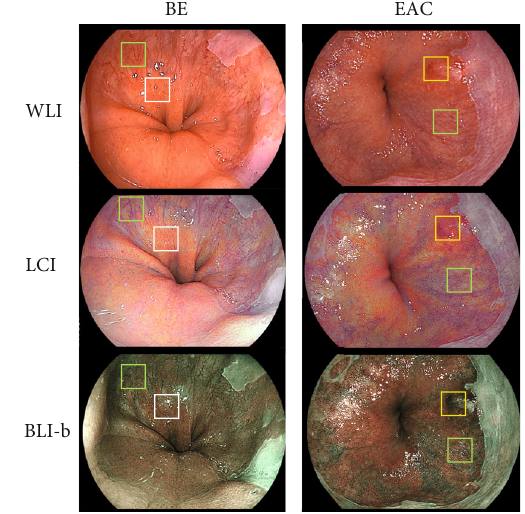
Figure 4: Representative cases for evaluating color di ff erence. The color di ff erence ( Δ E ∗ ) of the pixel values based on L ∗ a ∗ b ∗ color spaces within the region of interest was analyzed to evaluate the visibility of each color image. Green line squares indicate region of interest in normal Barrett ’ s mucosa. White line squares indicate region of interest in gastric mucosa. Yellow line squares indicate region of interest in normal Barrett ’ s mucosa. BE: white light imaging; LCI: linked color imaging; BLI-b: blue laser imaging